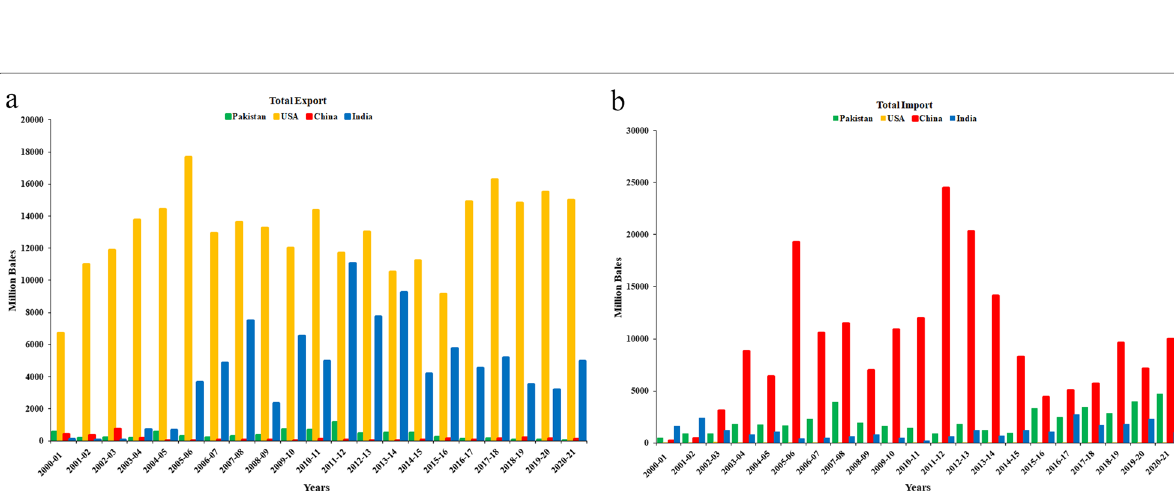
Fig. 3 Total export and import of cotton in Pakistan, China, USA, and India during 2000–2021. Source of data Cotton-statistics & facts (https:// www. stati sta. com/ topics/ 1542/